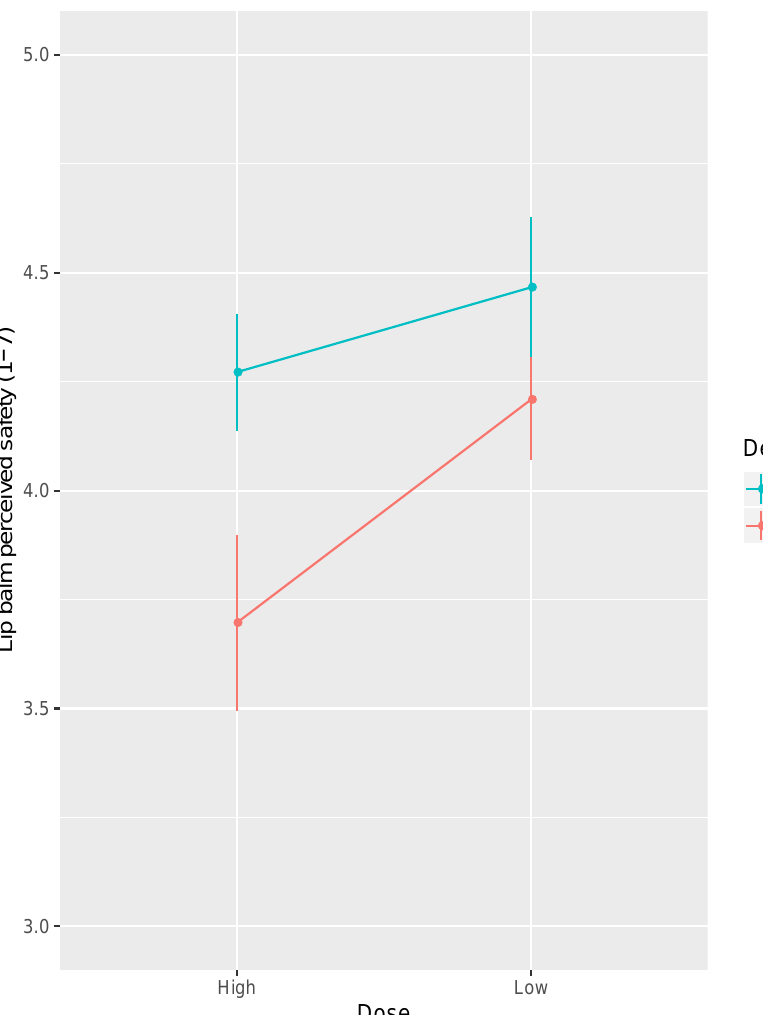
Figure 3. “Natural” and “low dose” descriptions of the mineral oil contained in lip balms improve safety perceptions.